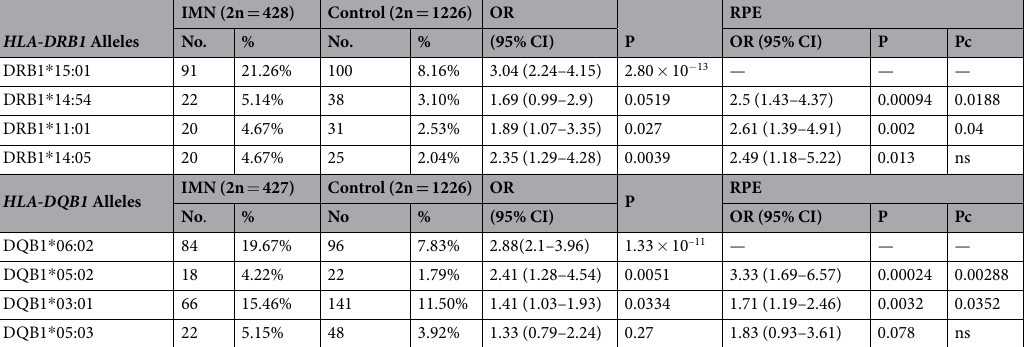
Table 5. RPE test results for HLA-DRB1 and HLA-DQB1 alleles. Each allele in each gene is the result of association after removing all the significant alleles listed above. (222 IMN vs. 701 Controls). Pc = P-value